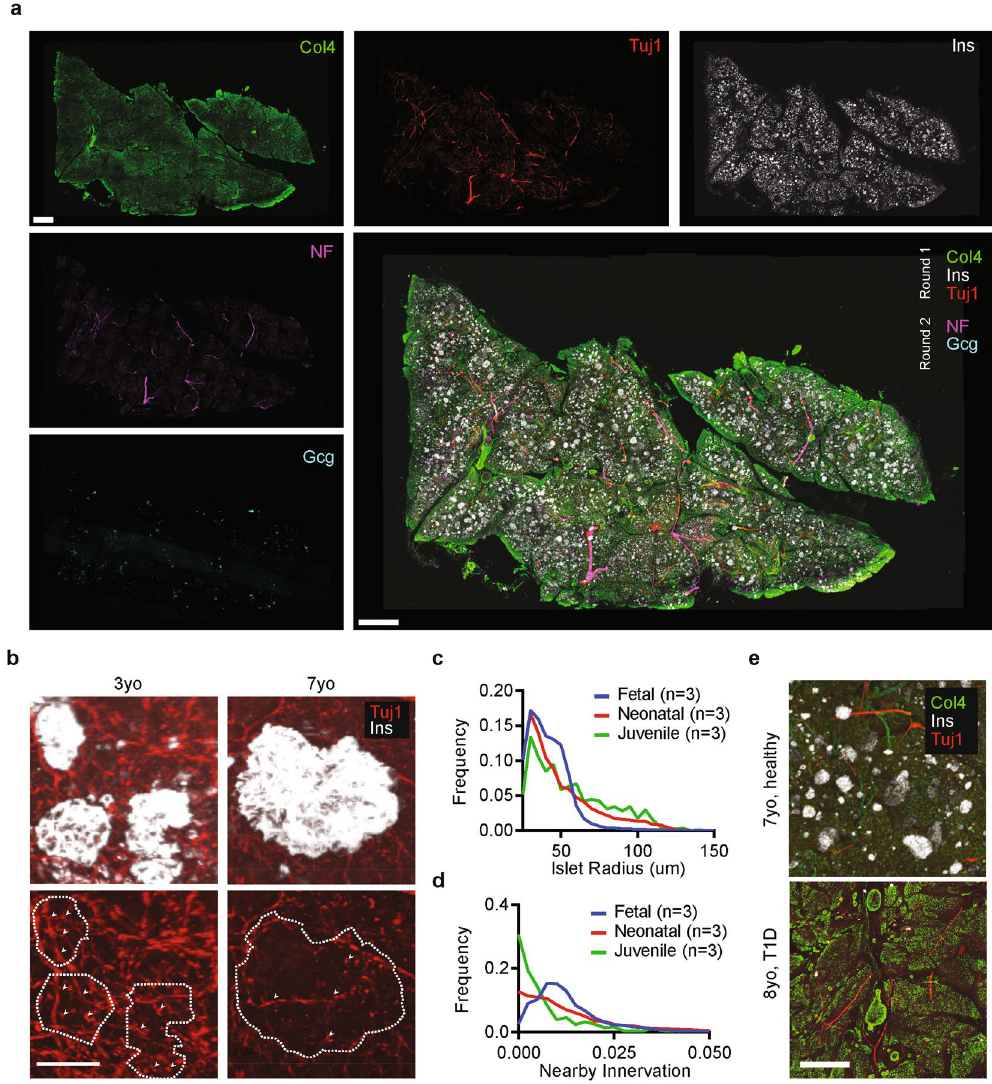
Figure 4. Neuroendocrine pancreas in human development. ( a ) CLARITY enables multi-round immunolabeling of large human tissues, such as in this 1 mm thick sample from a 3 year old human pancreas stained for Type 4 Collagen (Col4), β -tubulin (Tuj1), Insulin (Ins), Neurofilament (NF), and Glucagon (Gcg) over two rounds and manually registered together using image features. Samples were embedded in A1B1P4 hydrogel and cleared for 2–3 weeks at 60 °C. Scale bar = 1000 μ m. ( b ) 3D histological examination of two human pancreas samples at age 3 years and at 7 years illustrate differences in islet size (dashed lines) and innervation (arrows) during postnatal human development. Scale bar = 100 μ m. ( c ) Analysis of islet populations across fetal (n = 3), neonatal (n = 3, 0–3yo), and juvenile (n = 3, 4–8yo) human samples reveals a distribution shift toward larger islets as humans age. ( d ) Analysis of innervation surrounding and within islet populations across fetal, neonatal, and juvenile human samples reveal distribution shift toward reduced innervation in islet neighborhoods during postnatal human development. ( e ) CLARITY may enable assessment of relevant features in diseased tissue. Here, an 8yo subject with history of T1D shows minimal evidence of insulin-expressing islets compared to healthy age-matched control. Samples were cleared and stained under identical conditions but in separate experiments. Scale bar = 500 μ